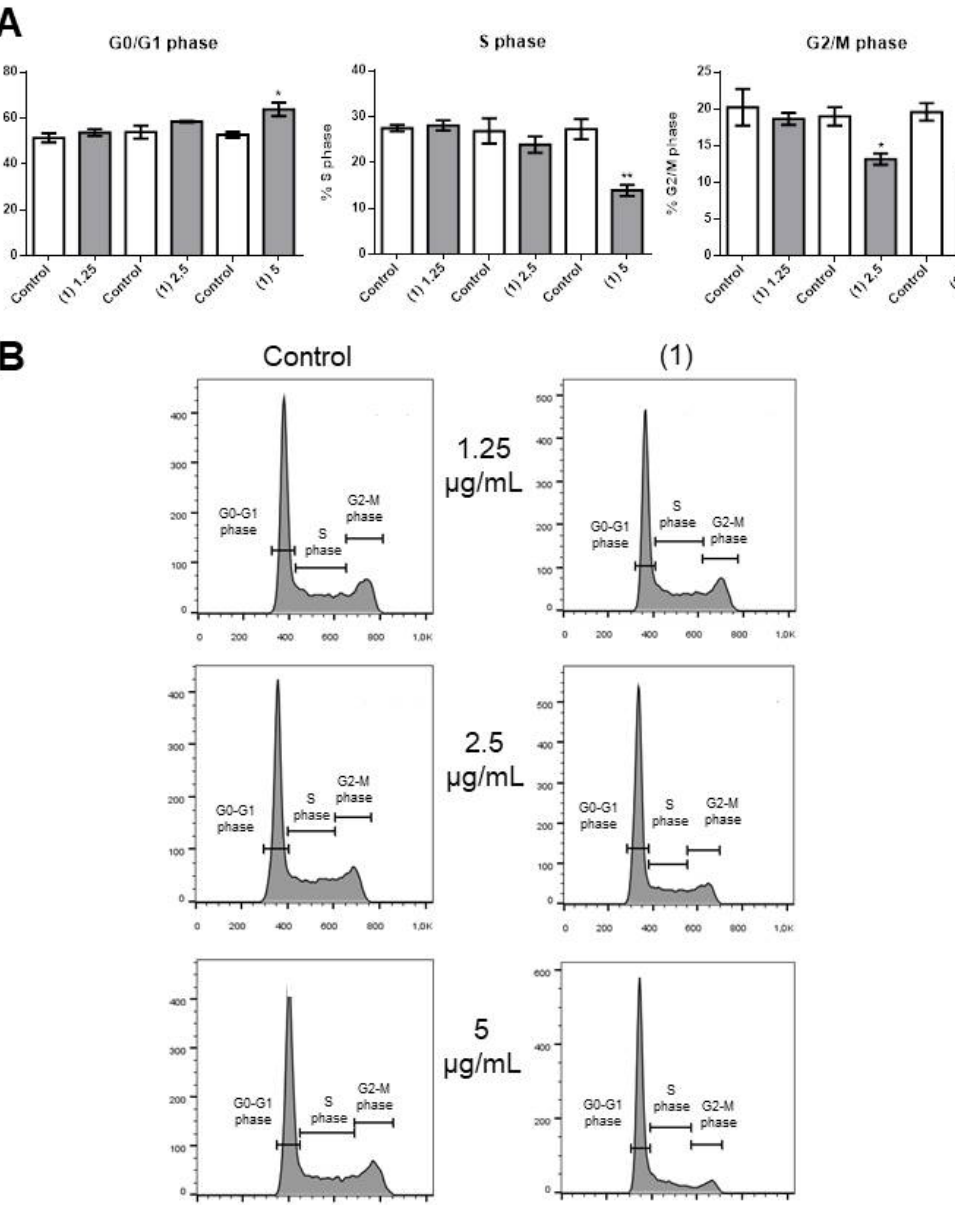
Figure 3. E ff ects of compound 1 on OCI-AML3 cell cycle progression. ( A ) Bars represent the percentage of cells in G0 / G1 (left panel), S (middle panel), or G2 / M (right panel) phases after 24 h of treatment with control vehicle (Control) or 1.25 [(1) 1.25], 2.5 [(1) 2.5] or 5 [(1) 5] µ g / mL of compound 1 . ( B ) Flow cytometry analyses of a representative experiment. Data from three independent experiments are reported as mean ± SEM. * p < 0.05, ** p <